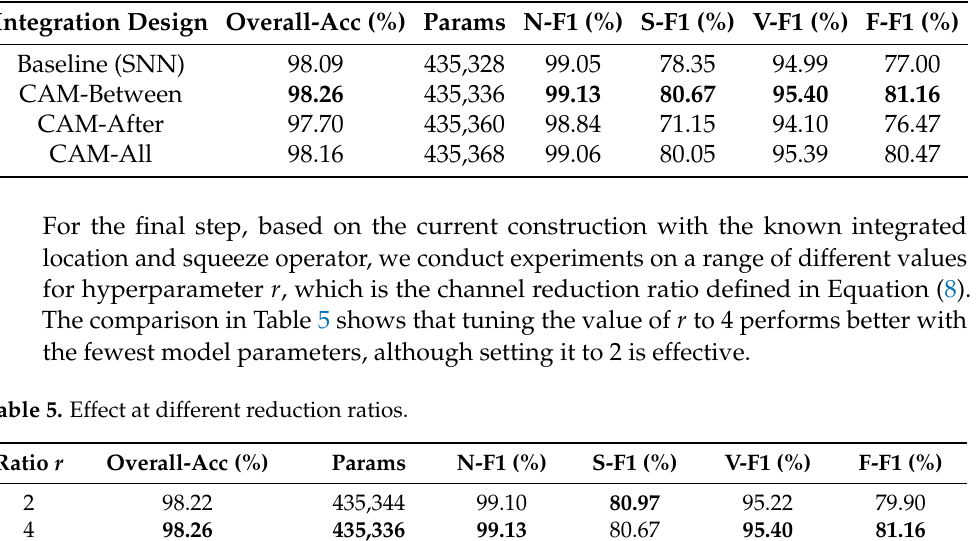
Figure 8. Three integration designs for the CAM. ( a ) CAM-Between block. ( b ) CAM-After block. ( c ) CAM-All block. Table 4. Effect of the CAM with different integration strategies.